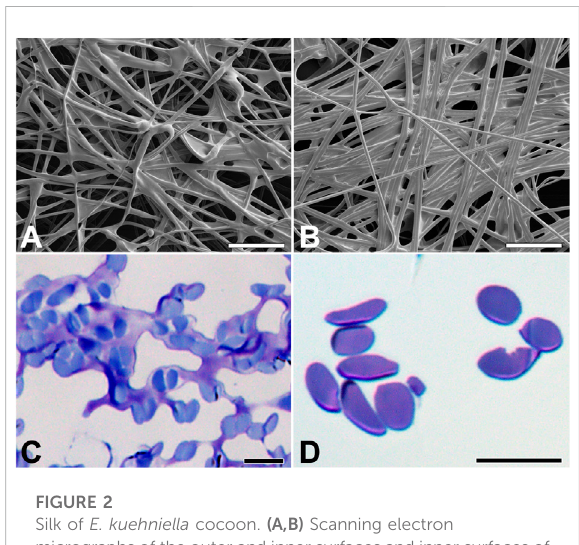
FIGURE 2 Silk of E. kuehniella cocoon. (A,B) Scanning electron micrographs of the outer and inner surfaces and inner surfaces of the cocoon, respectively. (C,D) Toluidine blue stained semi-thin sections of the silk fi bers of the cocoon before and after degumming, respectively. Scale bars: A,B = 50 μ m; C,D = 10 μ